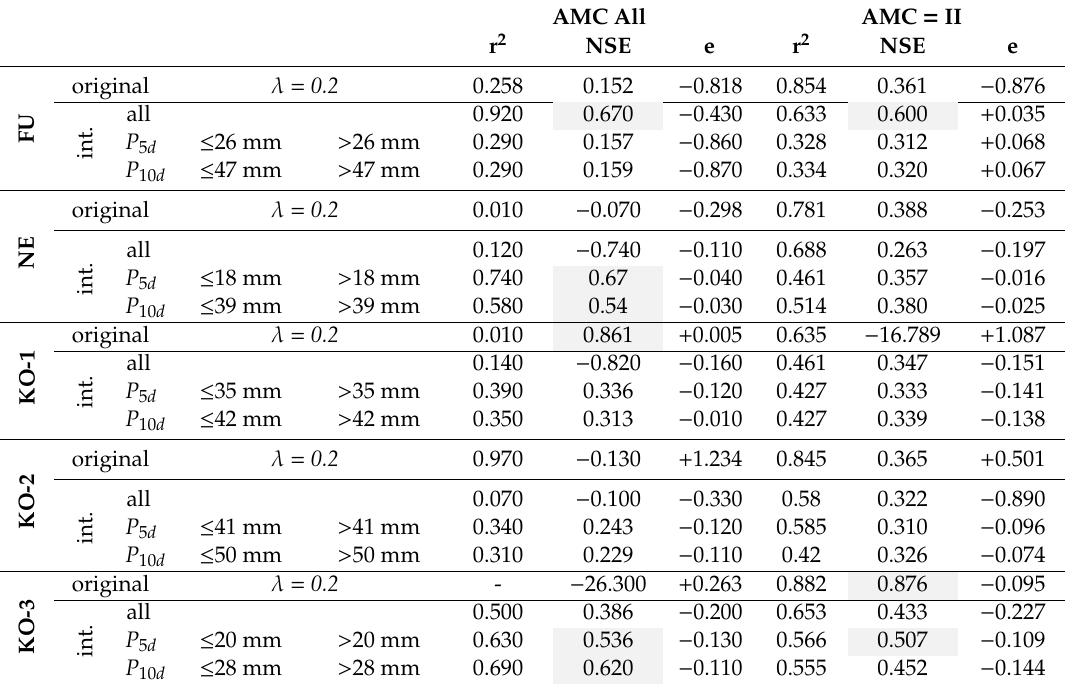
Table 7. Accuracy of direct runo ff simulations using regressions of λ according to P in the experimental catchments with (AMC all) and without (AMC = II) determination of AMC classes. NSE ≥ 0.500 indicating su ffi cient accuracy are